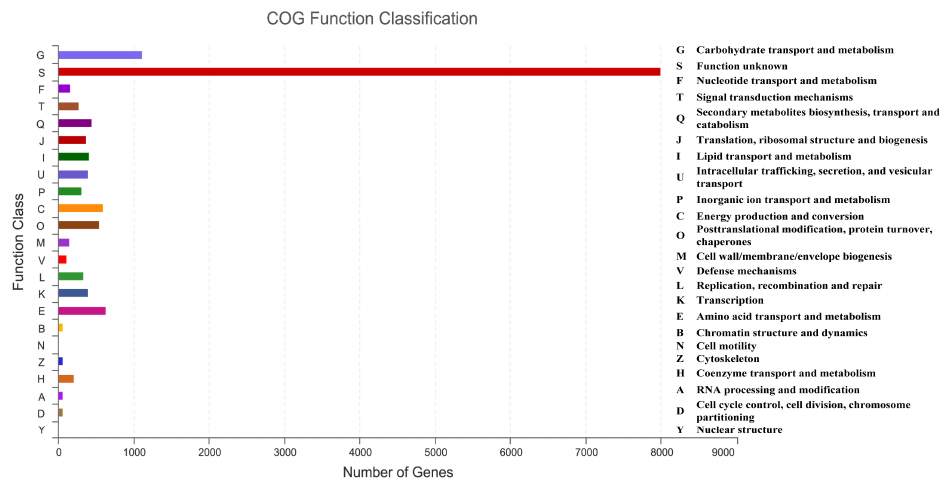
Figure 3. Clusters of Orthologous Groups of proteins (COG) analysis of D. alcacerensis CT-6 genes encoding the proteins.